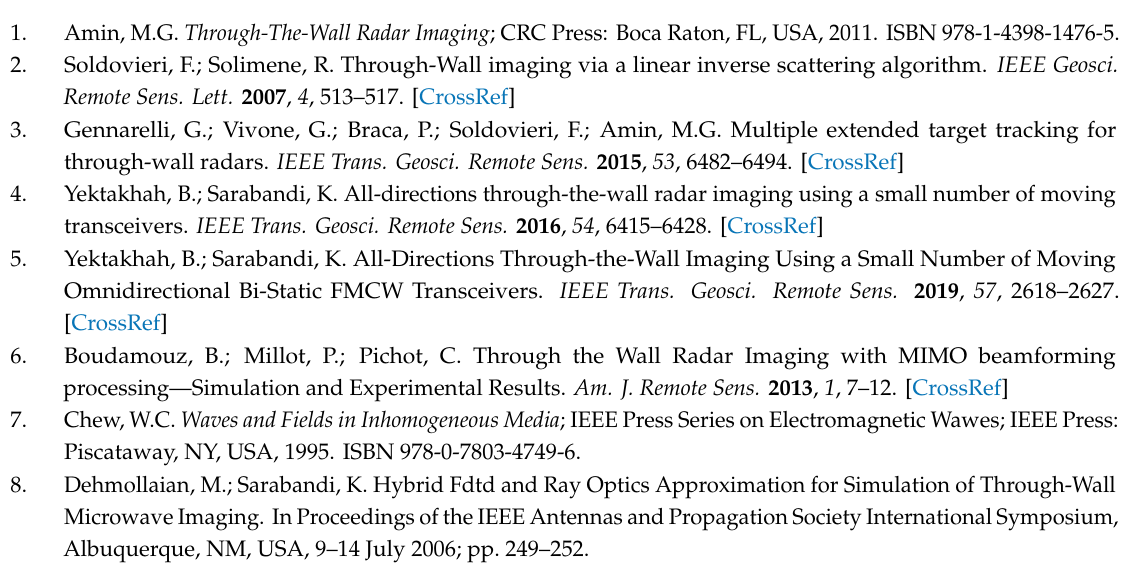
Figure 7. Behavior of the scaled entropy and of the reconstruction error versus the norm parameter.